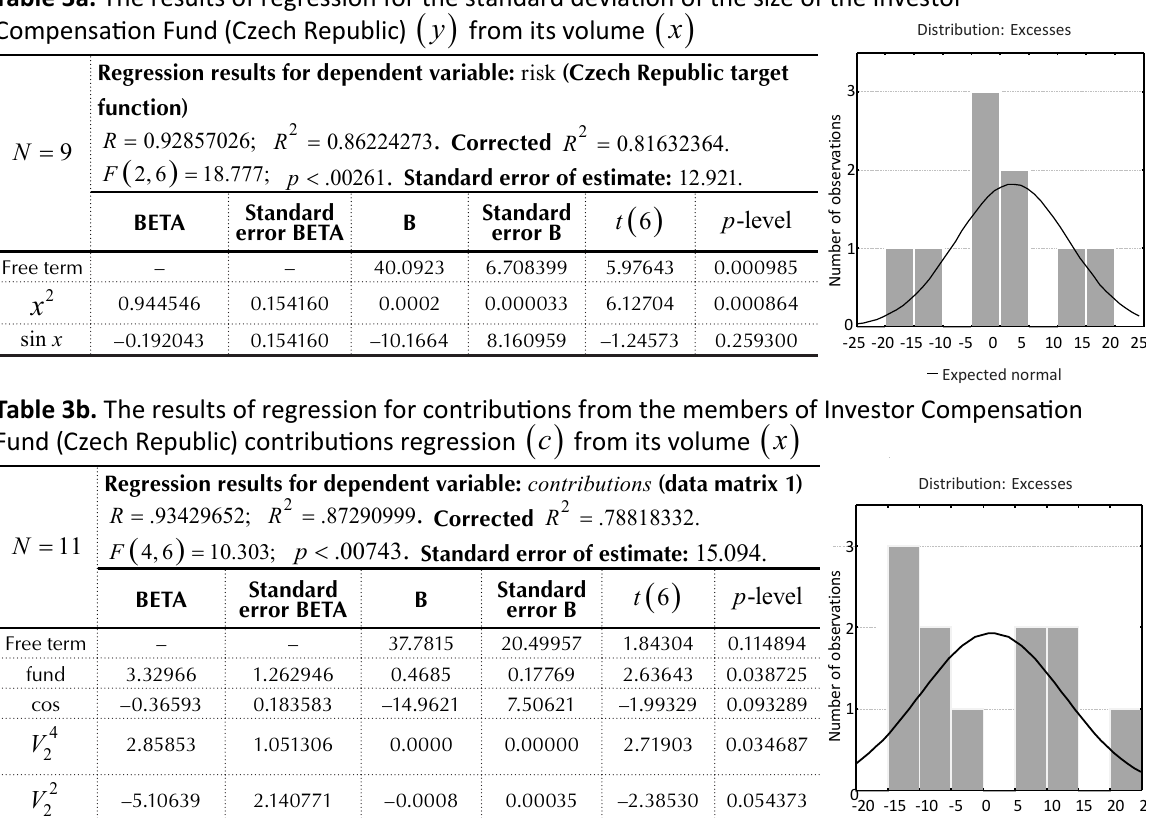
Table 3c. The results of regression for operating costs of the Investor Compensation Fund (Czech Republic)